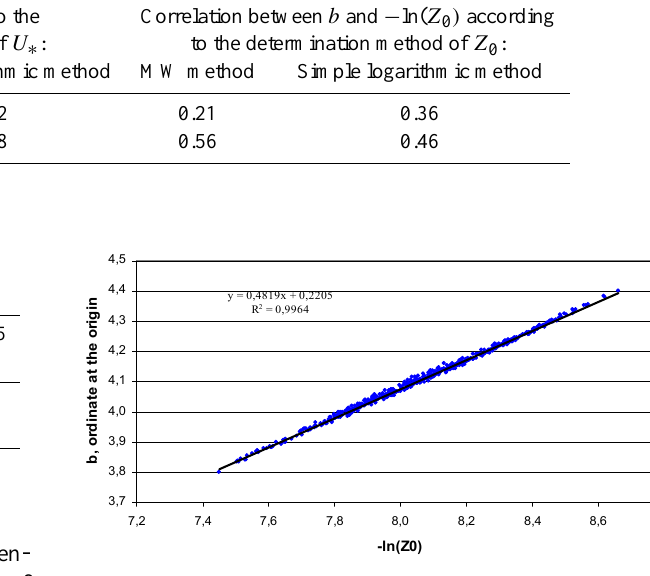
Figure 6: Linear regression between b and the opposite of the logarithm of the roughness Fig. 6. Linear regression between the ratio b 0 / a 0 and the opposite of length. the logarithm of the roughness length. 31